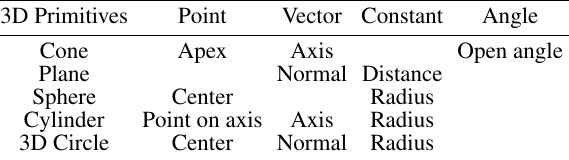
Table 1. Coefficients of 3D